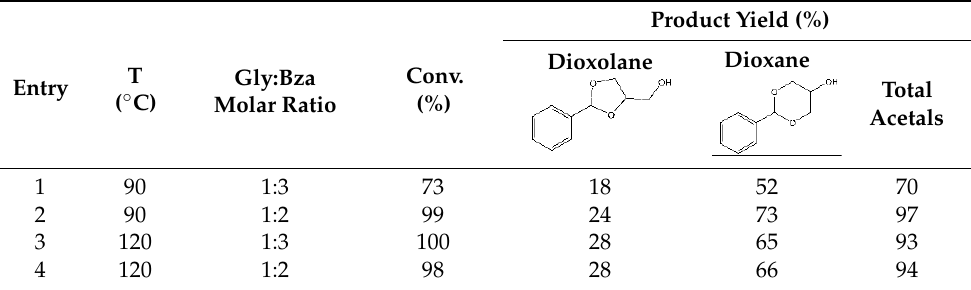
Table 1. Influence of the molar ratio Gly:Bza and temperature range 90–120 °C on the Bza/Gly reaction at 24 h, in the presence of 1 .